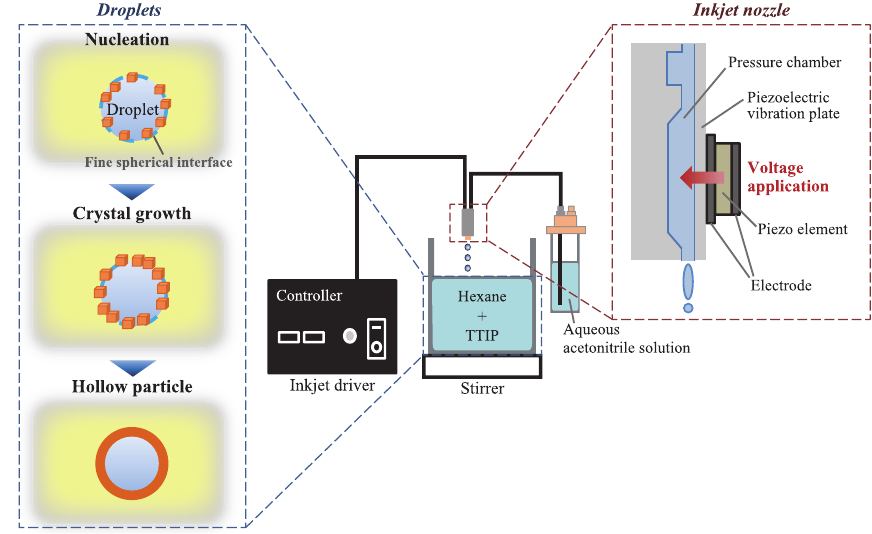
Fig. 1 Overview of the schematic experimental apparatus for instillation using an inkjet nozzle for liquid-liquid interfacial crystallization. Reprinted with permission from Ref. (Tominaga et al., 2018). Copyright: (2018)